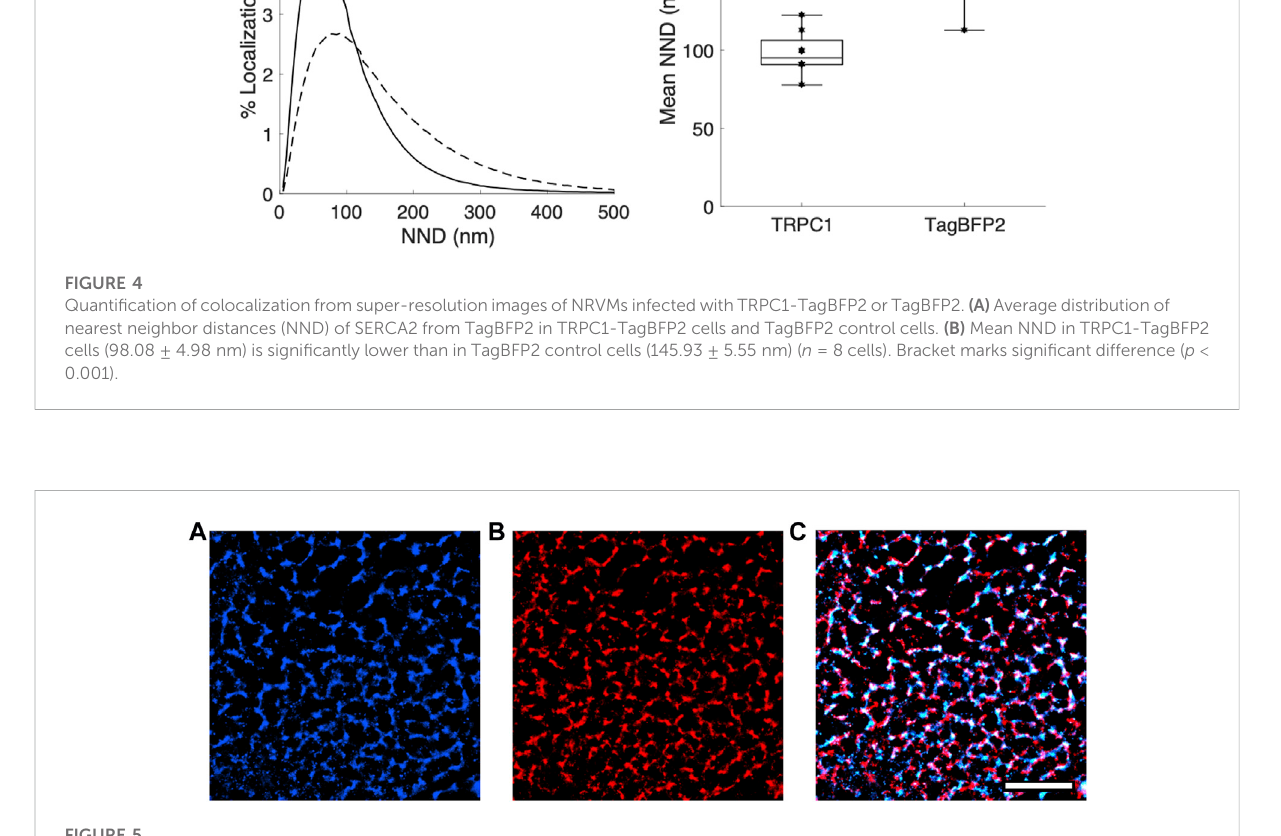
Super-resolution images of GCEPIAer-SNAP construct in TRPC1-TagBFP2 cells. (A) SNAP-Cell 647-SiR signal exhibits a network pattern strikingly similar to the (B) tRFP signal corresponding to TRPC1-TagBFP2. (C) The patterns exhibited from markers for both the GCEPIAer-SNAP construct and TRPC1-TagBFP2 construct reveal abundant overlap. Scale bar = 5